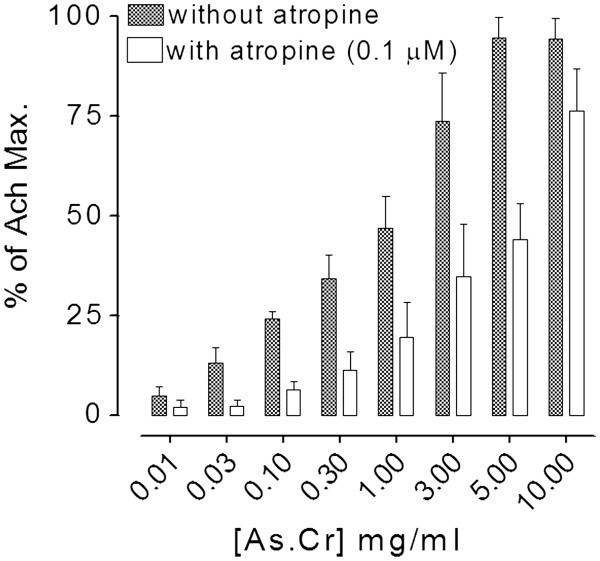
Bar-chart showing the concentration-dependentspasmogenic effect of thecrude extract ofA. spinosus(As.Cr) in the absenceand presence of atropine(0.1 μM) in isolatedguinea-pig ileum. The responses are shown as % of Ach (1 μM)-induced maximum contractile effect. Values are given as mean ± S.E.M., n = 4–5.